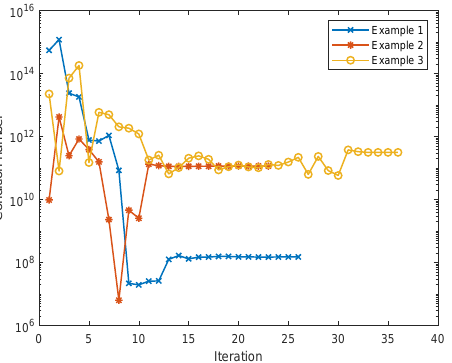
Figure 5. The condition number with respect to iteration number for each